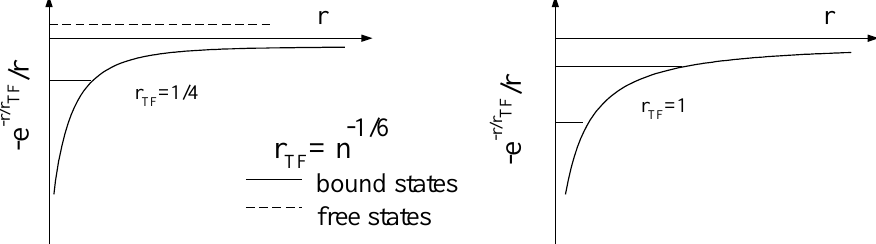
Figure 9. Screened defect potentials. The screening length increases with decreasing electron density n , causing states that were free to become